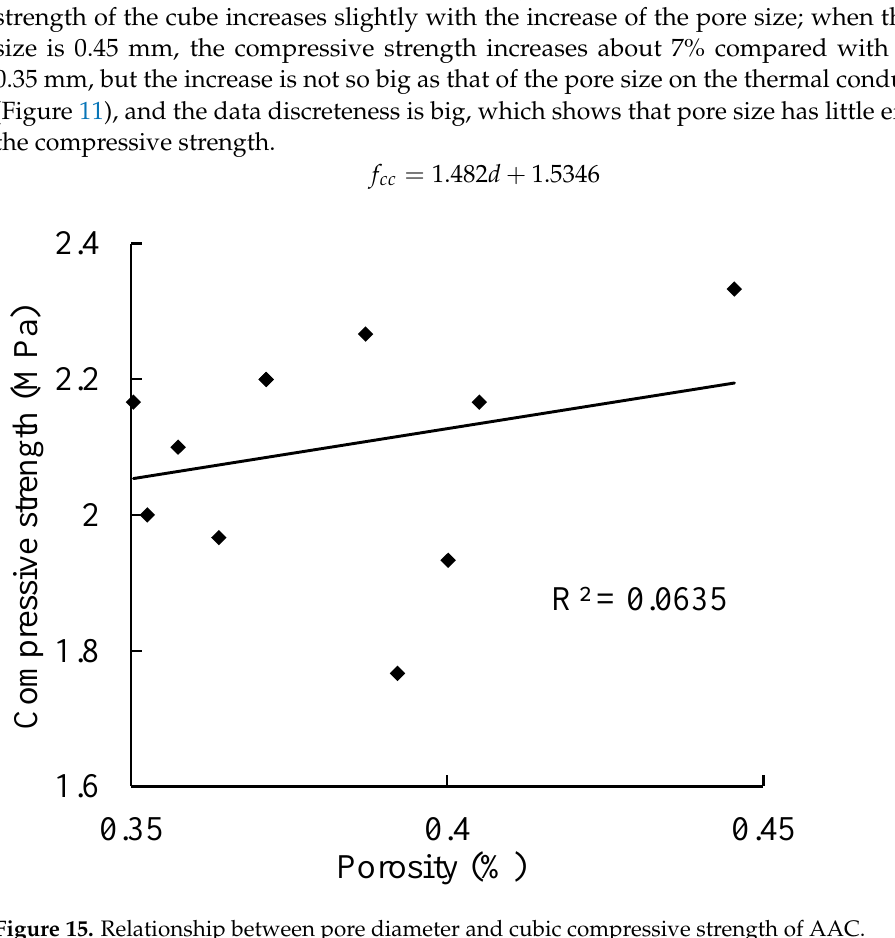
Figure 15. Relationship between pore diameter and cubic compressive strength of AAC.